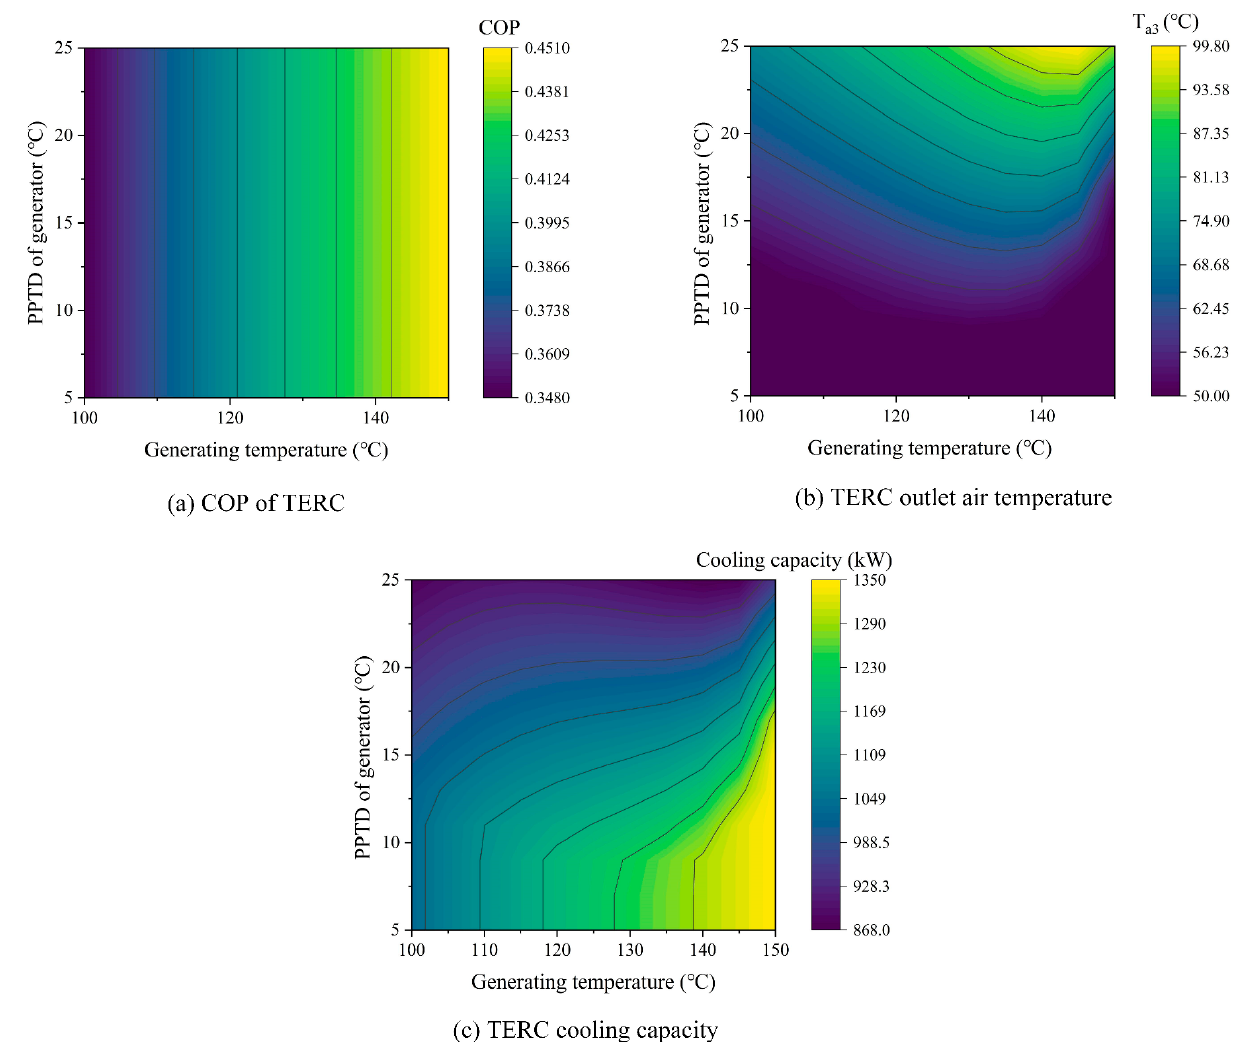
Figure 9. The influences of generating temperature and PPTD of the generator on the performance of the TERC: ( a ) COP; ( b ) outlet air temperature; ( c ) cooling capacity. Table 9. Optimization results and the corresponding system performance.